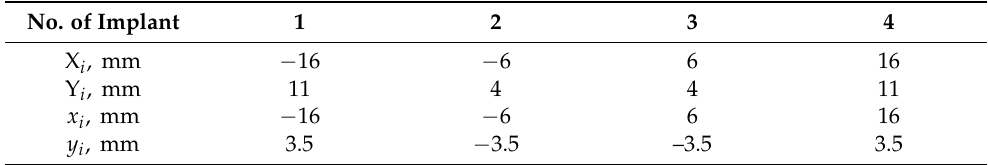
Figure 12. Numbering scheme and determination of the coordinates of the teeth of a removable overdenture (the second variant of implant placement): red—implant number, white—tooth number. The coordinates of the implants in the original and central coordinate systems are included in Table 3. The pole coordinates are still presented in Table 2. Table 3. Implant coordinates in the original and central coordinate system (the second variant of implant